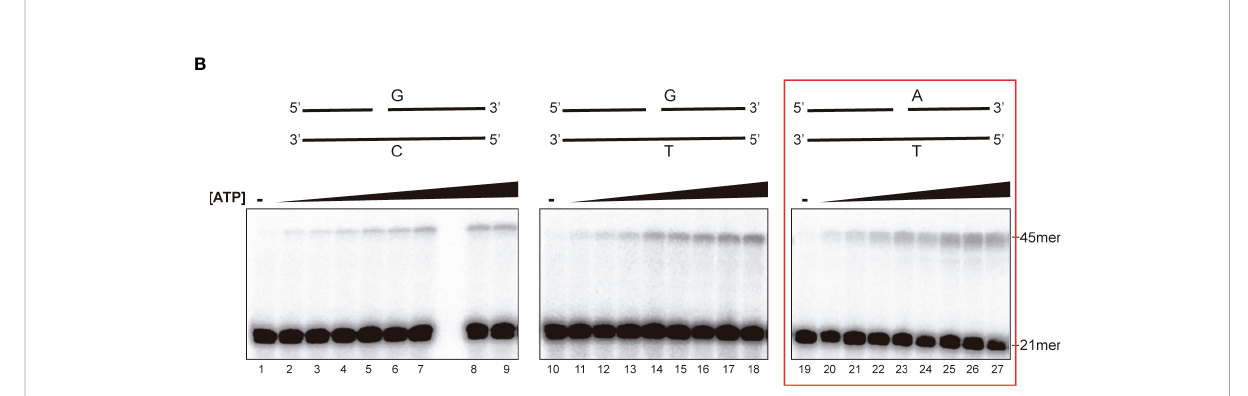
FIGURE 1B Steady-state kinetics of EhDNAligI on the G:T mismatch at different concentrations of ATP. Lanes 1 – 9 show EhDNAligI activity at different ATP concentrations in comparison to canonical G:C substrate, lanes 10 – 18 monitored ligase activity with a mismatched G:T substrate, lanes 19 – 27 indicate activity with the canonical A:T substrate. The 21mer substrate and the 45mer ligation products are marked with